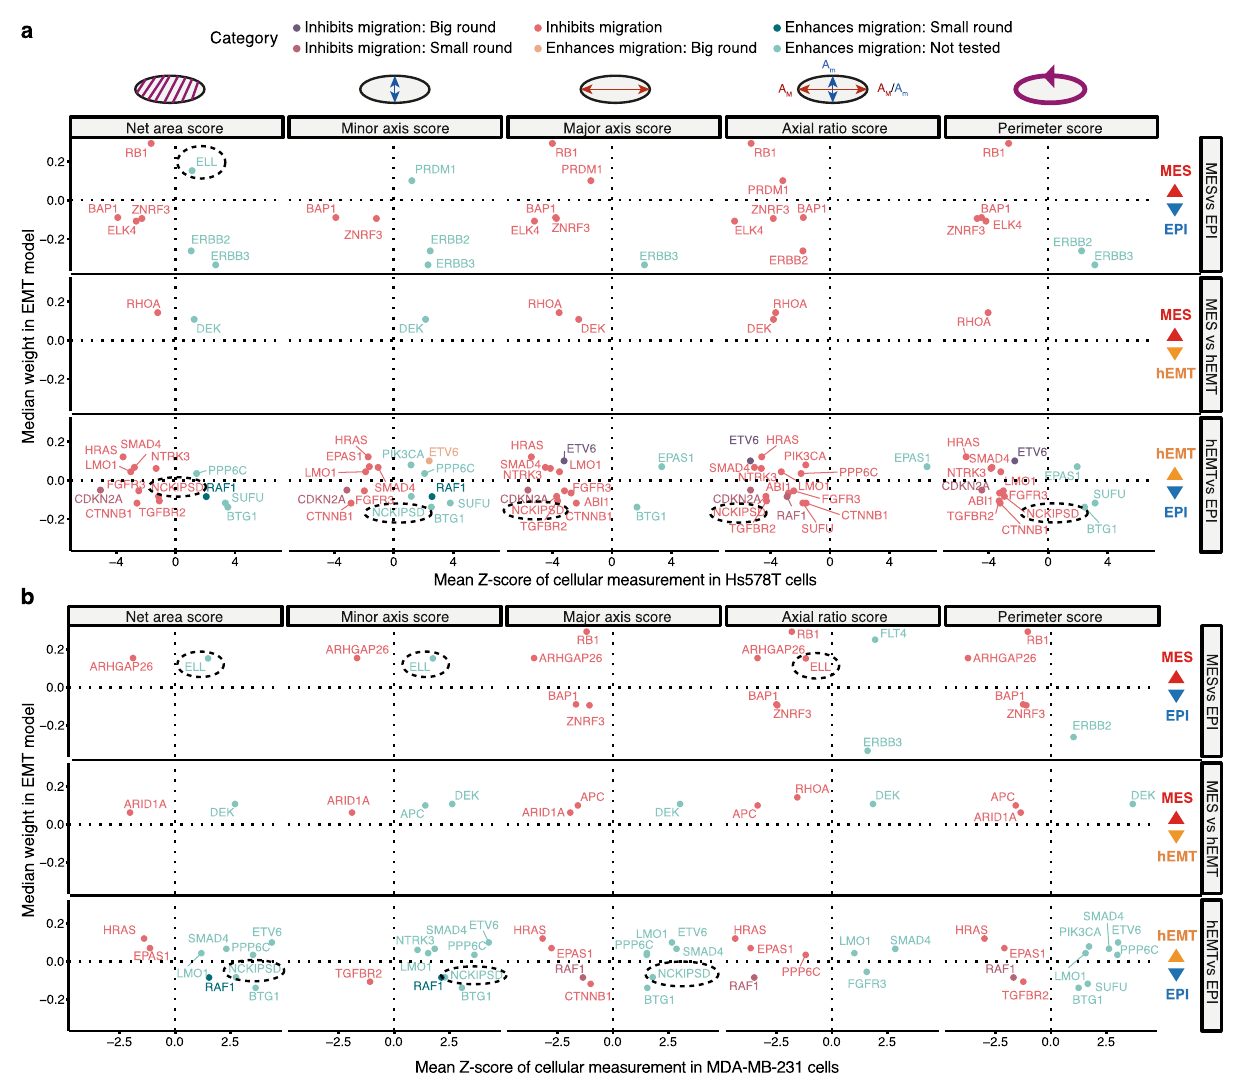
Fig. 4 | Validation of genomic associations with EMT using siRNA screens. a Gene knockdowneffects on cell migration abilitiesinHs578T a and MDA-MB-231 b celllines(datafromKoedootetal. 43 ).The x axisdepictsachangeinthefollowing measurements in the cells upon the knockdown: net surface area, length of minor ( A m ) and major ( A M ) axes, axis ratio (large/small: elongated cells, close to 1: round cells), perimeter score (larger — more migration). The y axis depicts the median weight of the gene in the model distinguishing two different EMT states. Larger absolute weights indicate more con fi dent associations with EMT. The genes are